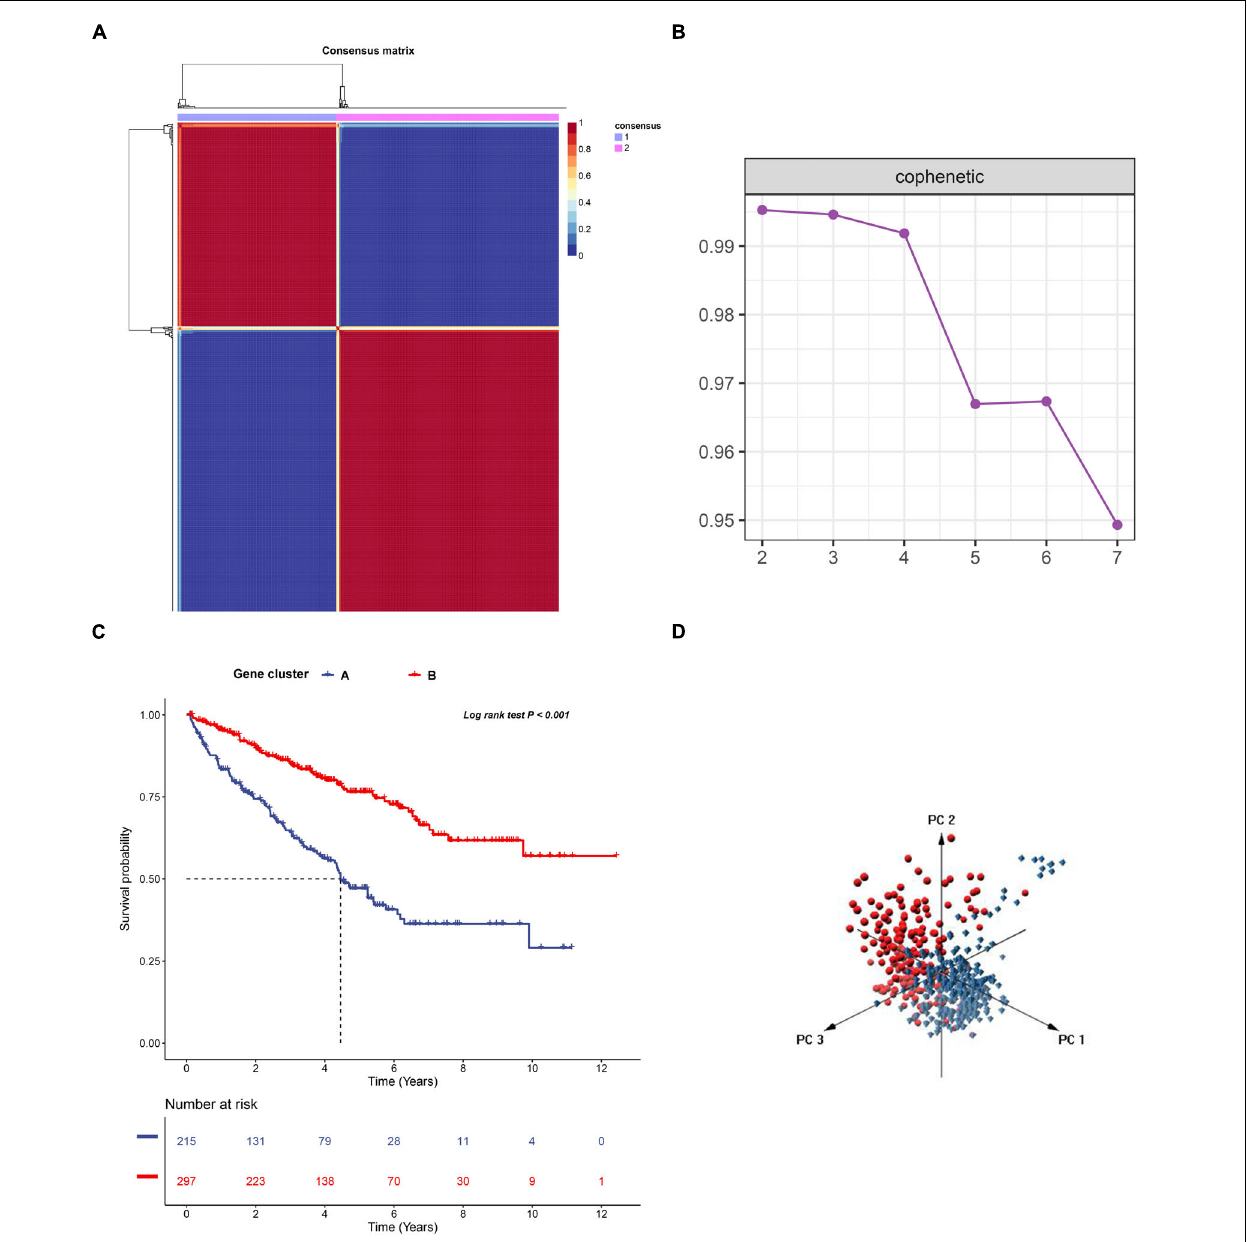
FIGURE 7 | The non-negative matrix factorization (NMF) clustering analysis to identify the genomic subtype of ccRCC based on the 274 DEGs. (A) Consensus matrix heatmap when k = 2. (B) The cophenetic correlation coefficient for the cluster number from 2 to 7. (C) KM survival curve analysis for the overall survival of the two subtypes in ccRCC. (D) Principal component analysis (PCA) for the 512 ccRCC patients, each dot represents a single